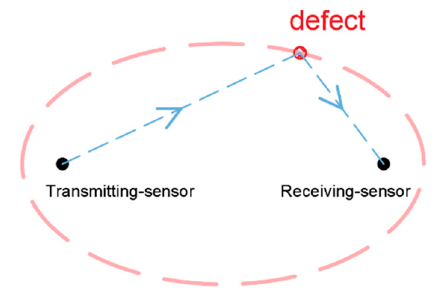
Figure 1. Ellipse trajectory of defect location.